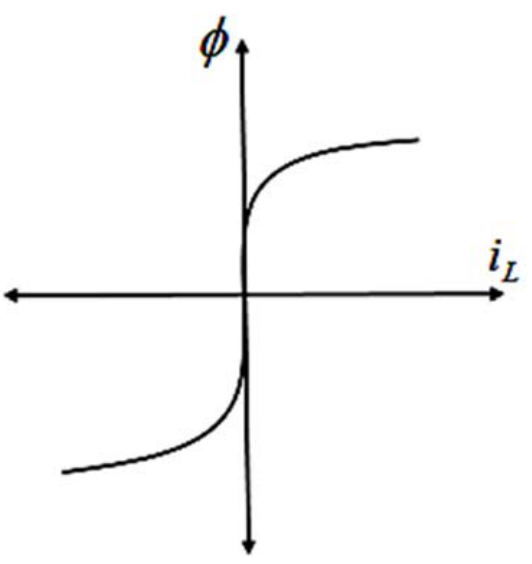
Figure 4. The magnetization curve of transformer inductance.